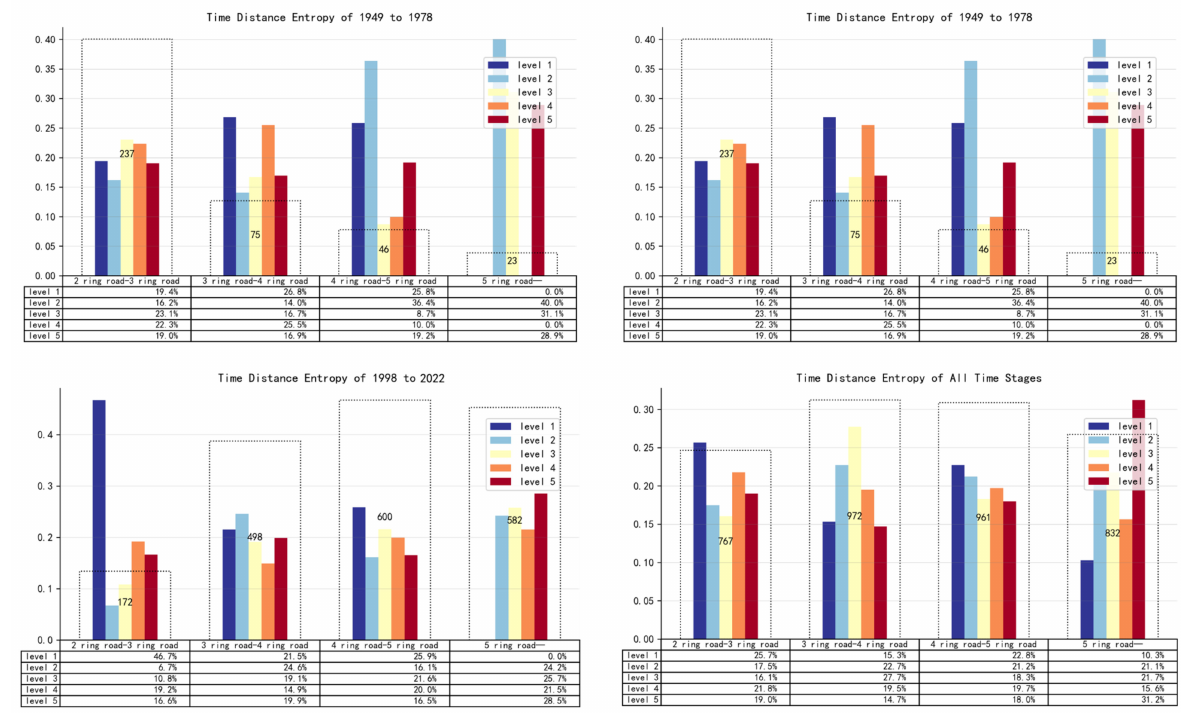
Figure 11. Measurement results of the Time Distance Entropy